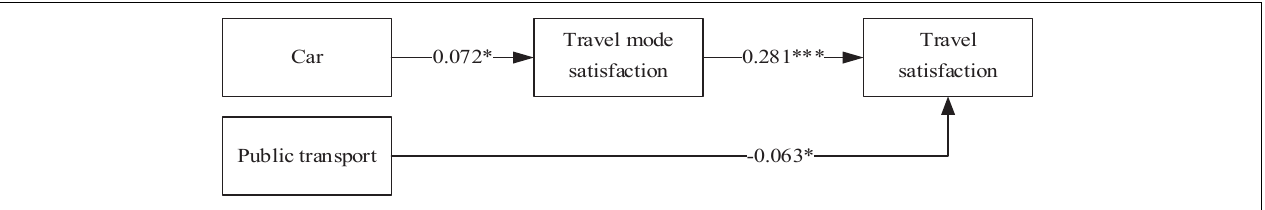
FIGURE 10 | Travel mode and travel mode satisfaction. *Represents p value < 0.1 and ***Represents p value < 0.01.